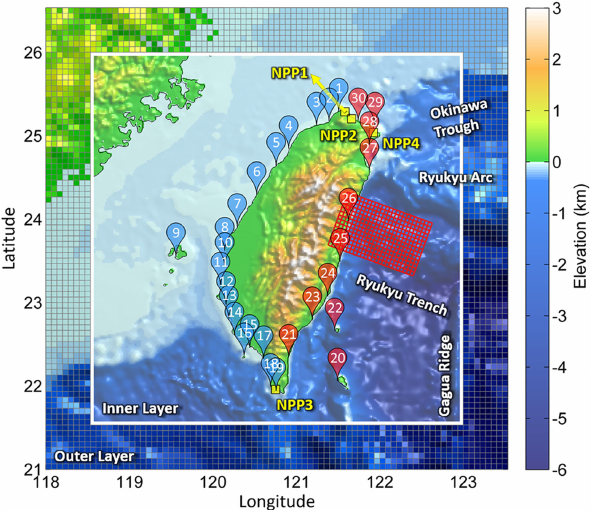
Figure 2. The map of Taiwan shows the fault model and recording stations used in this study. The bathymetry is divided into two layers with different resolutions. The resolution of the outer layer is 4min, and the resolution of the inner layer is 1min. The red grid denotes the potential fault model (5 × 5km 2 grid size). The pins represent 30 tidal gauges of the CWB. The red and blue colors indicate stations on the eastern and western sides of Taiwan, respectively, and the yellow squares represent the sites of nuclear power